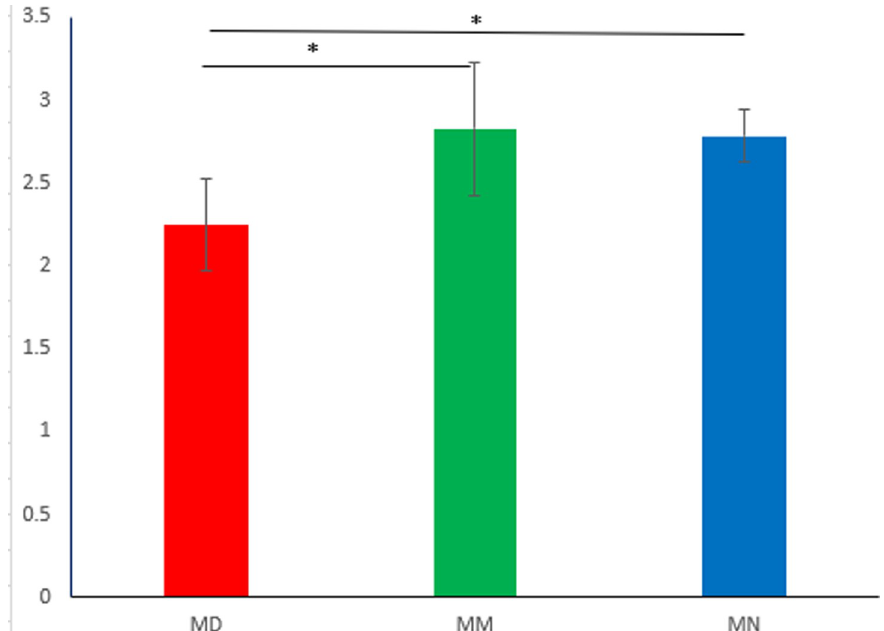
Fig 3. Alpha diversity analysis of the Shannon index in the normal group (MN), the model group (MM) and the treatment group (MD), � P < 0.05.